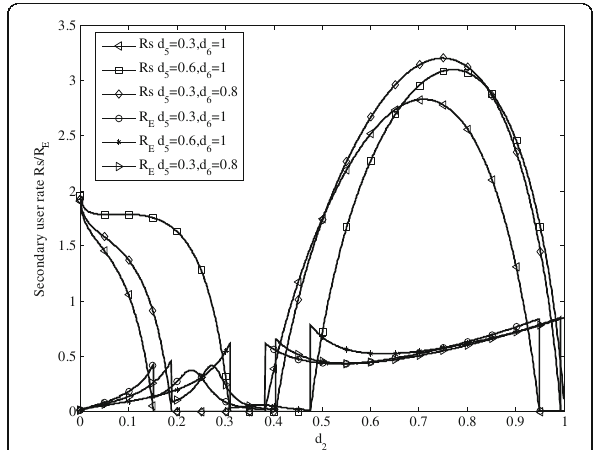
Fig. 6 Transmission rate of secondary system and eavesdropper wiretapped versus d 2 with different location of